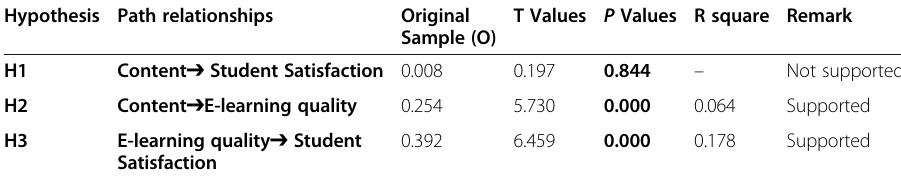
Table 5 Estimated path relationships Hypothesis Path